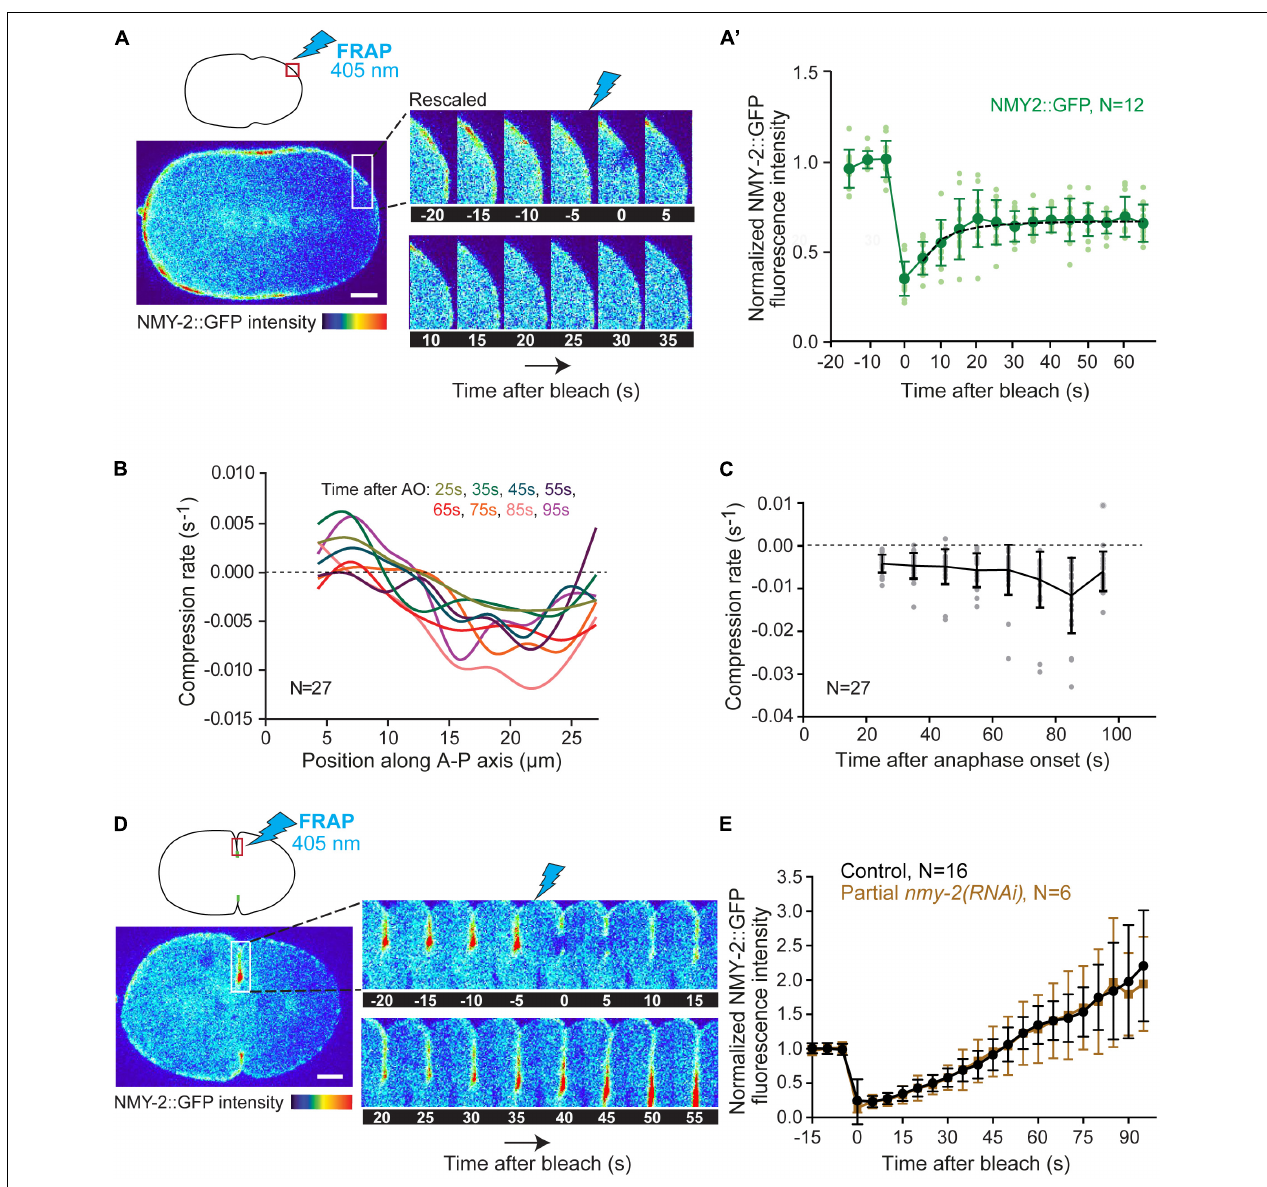
FIGURE 3 | Cortical myosin turnover and flow-induced compression rates. (A) Schematic showing the photobleached region at the posterior pole of the embryo at shallow deformation (top left) and selected images from a time-lapse series showing NMY-2::GFP fluorescence over time pre- and post-bleaching. (A’) Quantification of NMY-2::GFP fluorescence recovery after photobleaching at the posterior pole. Data from individual embryos (light green) and the mean ± SD (dark green) are plotted. The black dashed line is the single exponential fitting curve from which the half time of recovery and myosin k off were extrapolated. (B) Average compression rate by flow calculated as the spatial derivative of the longitudinal flow profiles for each position along the anterior-posterior (A-P) axis of the embryo from 25 to 95 seconds after anaphase onset (AO). Compression is uniform in the equatorial region (15–25 µ m). Colors represent different time intervals as indicated. (C) Average compression rate by flow over time after anaphase onset for the region of equatorial compression (15–25 µ m). Data from individual embryos (gray) and the mean ± SD (black) are plotted. (D) Schematic showing the photobleached region just behind the tip of the ingressing furrow after back-to-back membrane configuration is achieved (top left) and selected images from a time-lapse series showing the NMY-2::GFP fluorescence over time pre- and post-bleaching. (E) Quantification of NMY-2::GFP fluorescence recovery after photobleaching in the ingressing furrow in control and NMY-2 depleted embryos. The mean ± SD is plotted. N is the number of embryos analyzed. Scale bars, 5 µ